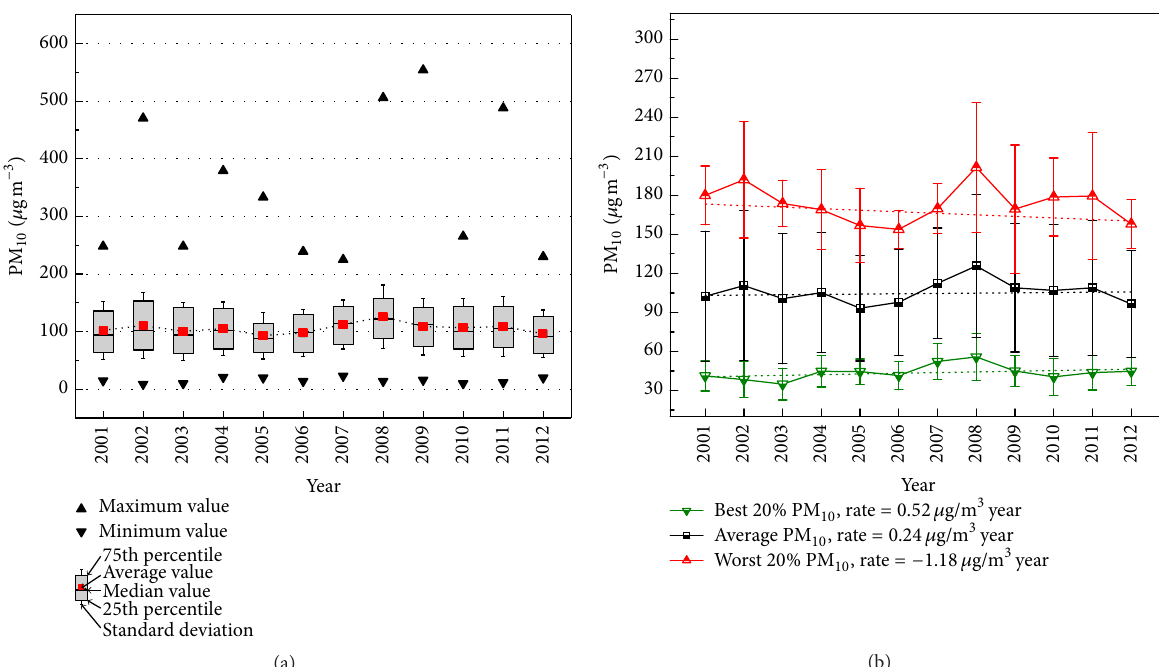
Figure 2: (a) Statistical box chart of long-term trends for the PM 10 concentration in Hefei during the period from 2001 to 2012. The range of the box represents the interquartile range of the data. (b) The worst 20% and 50% and best 20% region-average PM 10 concentration trends in Hefei during the period from 2001 to 2012. Dotted lines are the linear regression curves of the corresponding trend